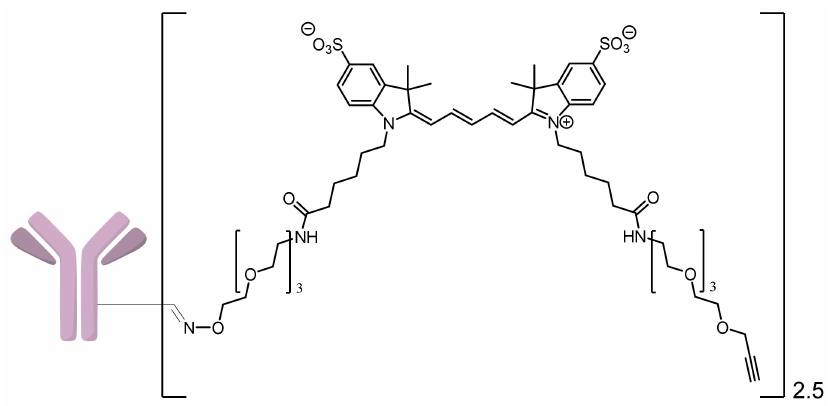
Figure 12. The structure of conjugate 13 . Conjugate 3 The 6H8 antibody (1.79 mg, 11.9 nmol) was modified with reagent 2 according to modified general procedure A: reagent 2 was added in 8 portions of 0.5 equiv. every 10 min (total reaction time of 80 min); 0.54 mg (3.6 nmol, 30%) of conjugate 3 (Figure 13) were obtained with an average degree of labeling of